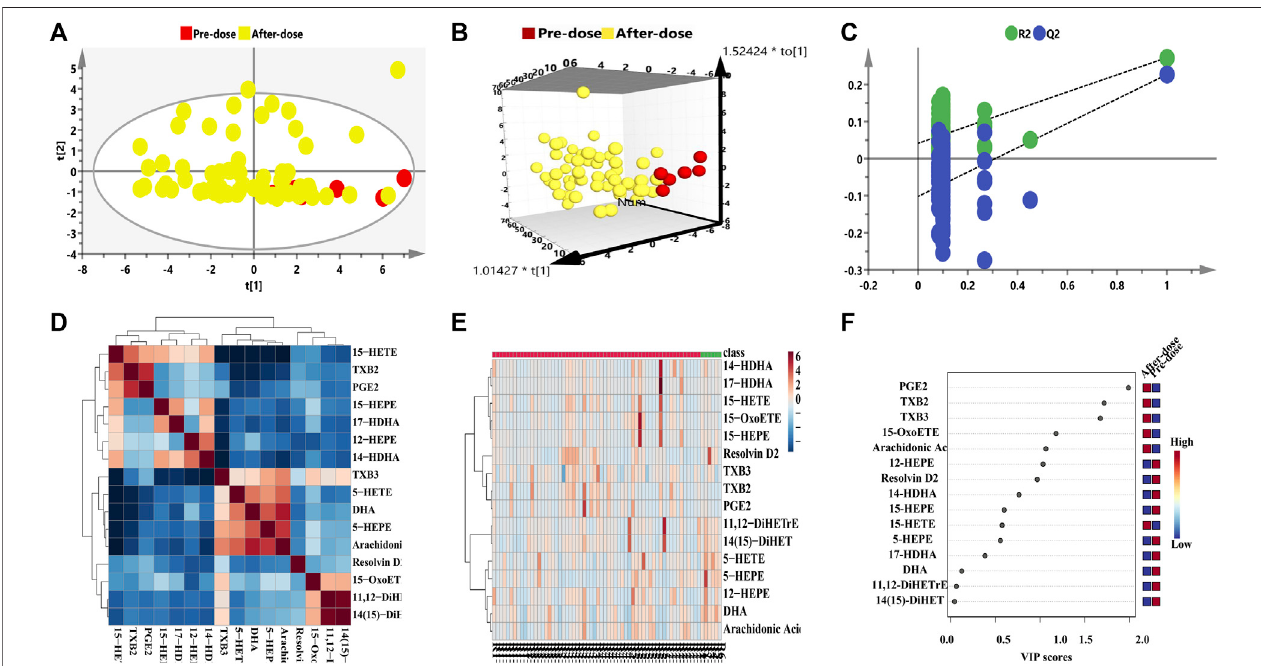
FIGURE3| Eicosanoidmetabolicpro fi lingofremdesivirbeforeandaftertreatment. (A) PCAscoreplot; (B) OPLS-DAscoreplot; (C) Randompermutationtestwith 100 iterations, and no over fi tting was observed. (D) Hierarchical cluster analysis of metabolite – metabolite correlation in response of remdesivir treatment. (E) Heatmap clustering of eicosanoid metabolomic pro fi ling before and after treatment by remdesivir. (F) Rank of the different metabolites (the top 10) according to the VIP score and the coef fi cient score.